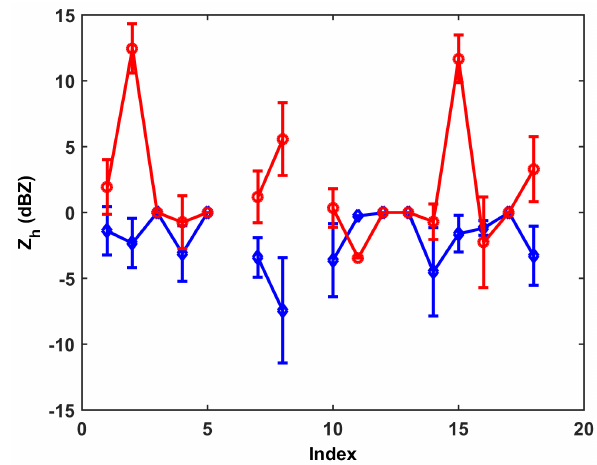
Figure 9. The averaged raw Z h for Ku- and Ka-bands. The Z h was randomly selected from 20 of 85 RHI scans with Ku-band Z h < 0dBZ, range < 1km, and Ka-band SNR >